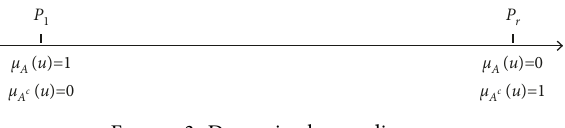
Figure 3: Dynamic change diagram.